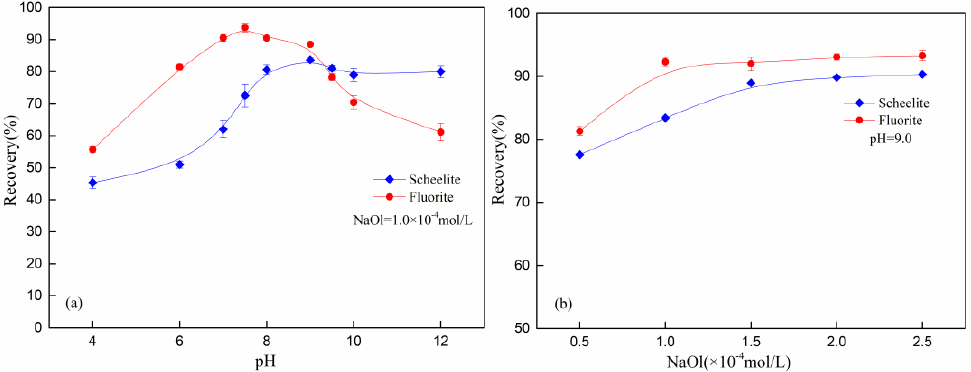
Figure 3. Recovery of scheelite and fluorite as a function of the ( a ) pH and ( b ) NaOl concentration.